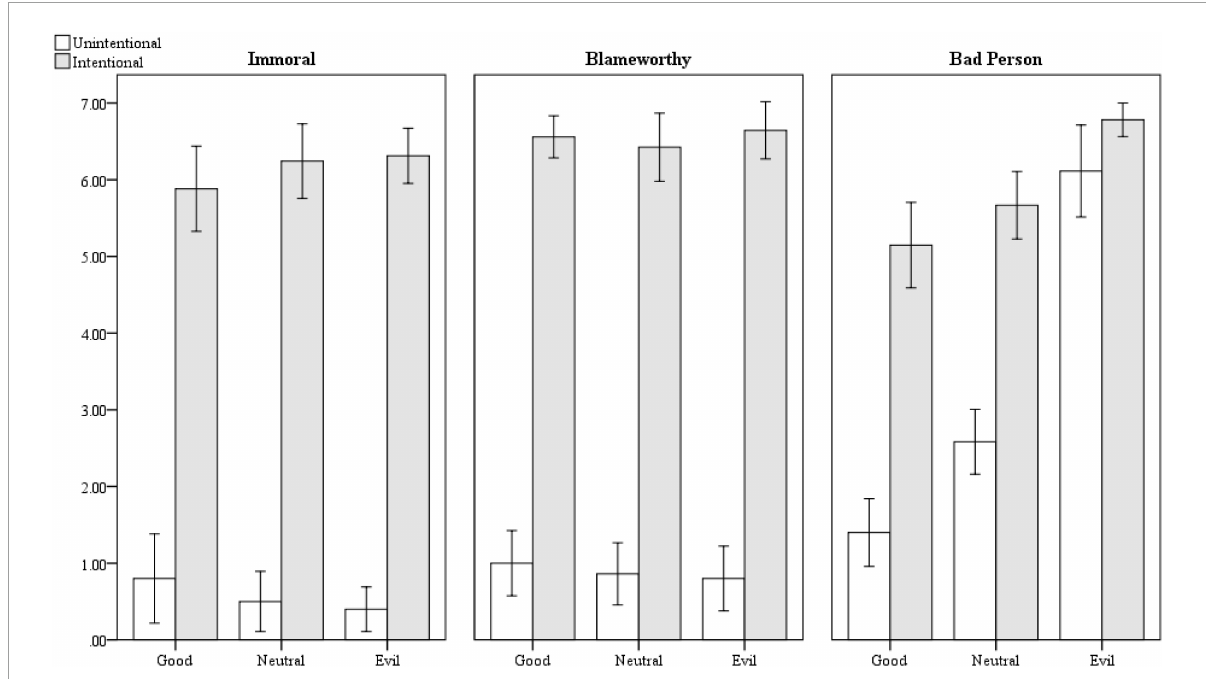
FIGURE3 Moral contamination for intentional and unintentional bad actions. Error bars represent 95% confidence